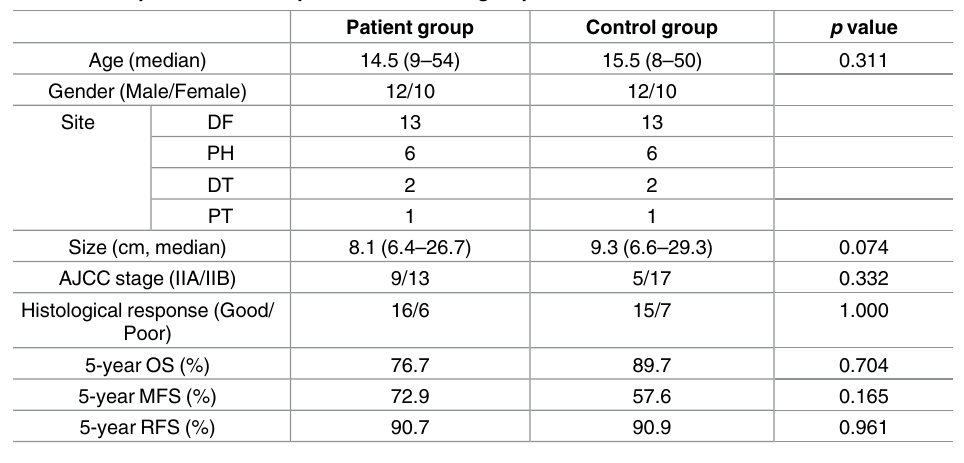
Table 2. Comparison between patient and control